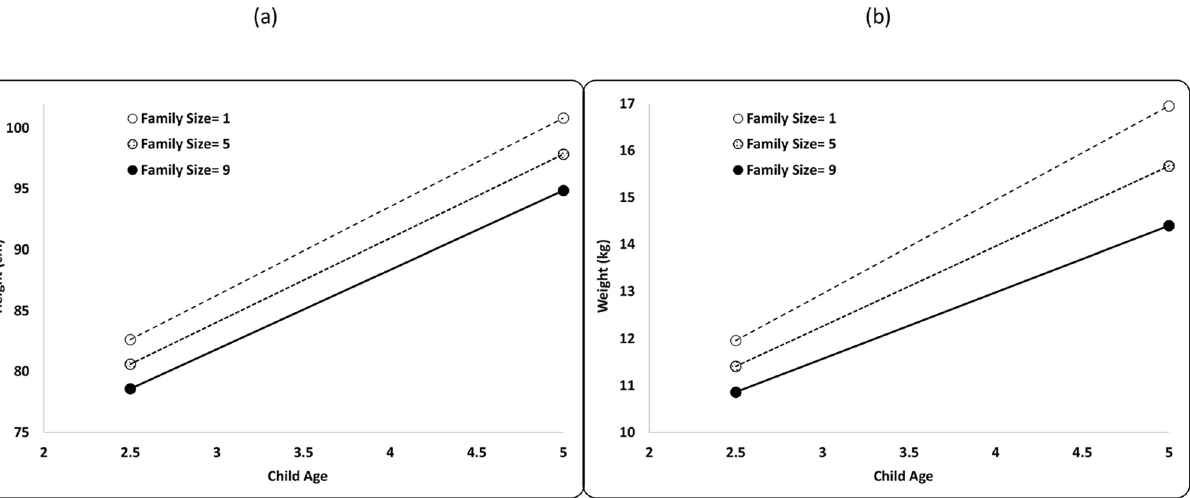
Fig 1. Growth performance stratified by family size (FS) for Maya children ages 2.5 – 5.0. Lines plot predicted (A) height (cm) and (B) weight (kg) by age for boys and girls in a family with 1, 5 and 9 children (drawn from S1 Table Models 1a-b).